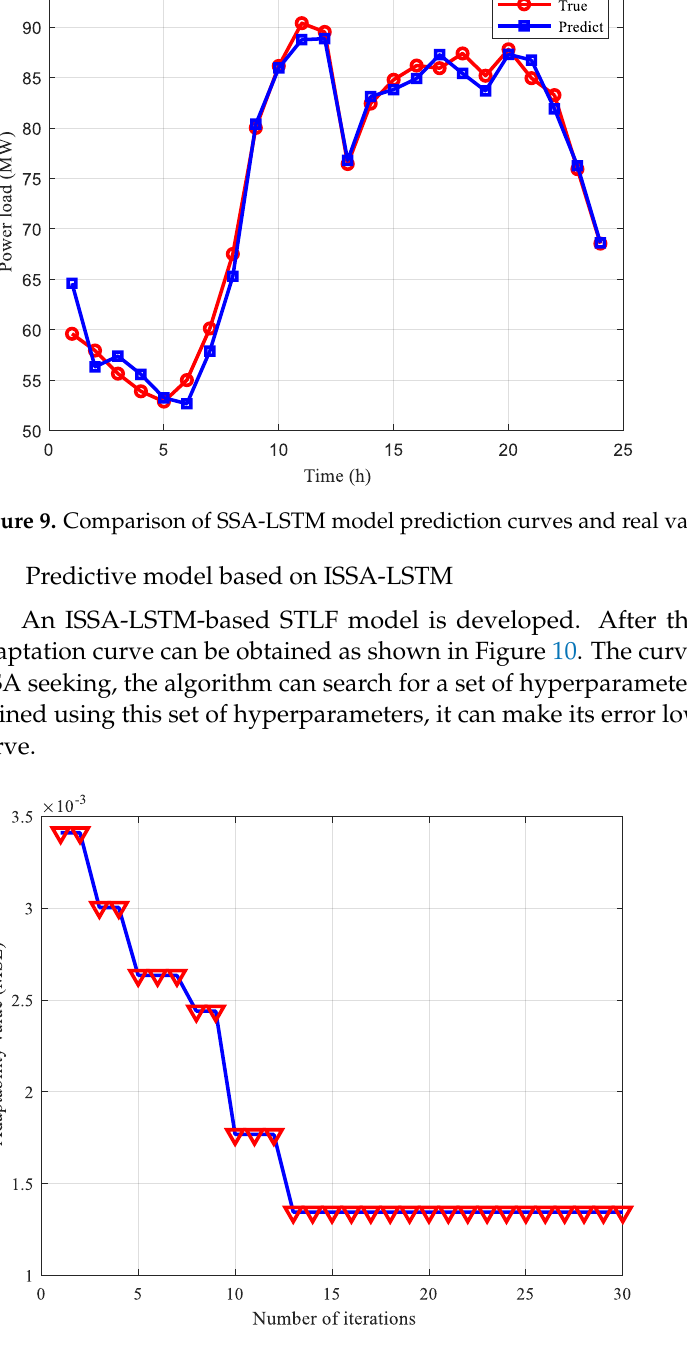
Figure 10. ISSA adaptation curve.